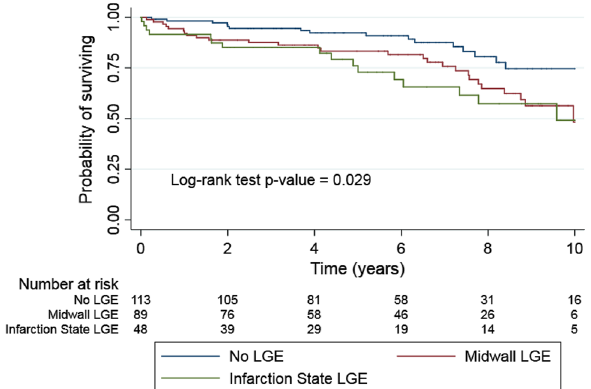
Figure 1. Kaplan–Meier estimator plot of survival in patients with no gadolinium enhancement, midwall enhancement and infarction pattern enhancement. This plot indicates significantly worse prognosis in the patients with either form of enhancement (midwall or infarction) out to 10 years (log rank P = 0.029). Patients with a mixed pattern of LGE were categorized according to the predominant pattern of fibrosis.